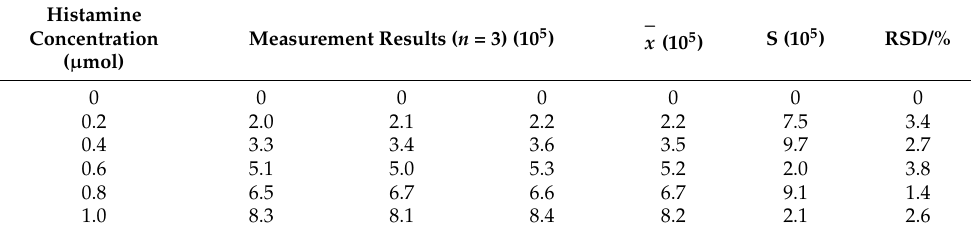
Table 1. Precision analysis of the fluorometric ( ∆ F ) determination results.